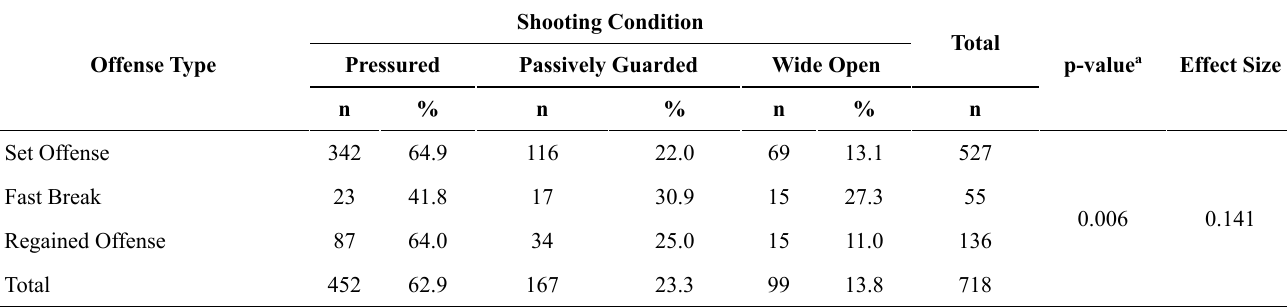
Table 2. Relationship between offense type and shooting condition.